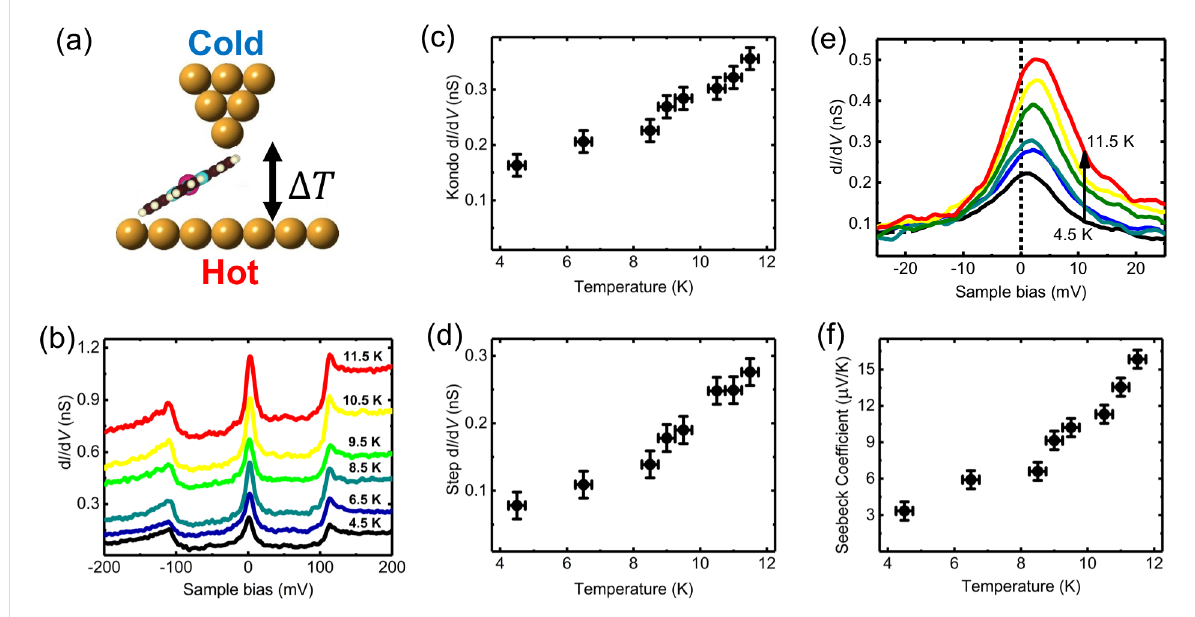
Figure 3: (a) Schematic view of the STM junction; the tip temperature T t = 4.5 K is kept constant during the experiment. (b) d I /d V spectra of the MnPc junction at different sample temperatures T s , shifted vertically for clarity. The feedback loop has been opened at 0.1 nA, − 0.30 V. (c) Maximum conductance of the zero-bias peak as a function of the sample temperature T s . (d) Conductance step at positive bias as a function of the sample tem- perature T s . (e) Close-up of the d I /d V spectra showing the zero-bias values (vertical doted line). (f) Seebeck coefficient as a function of the sample temperature T s extracted from the value measured in